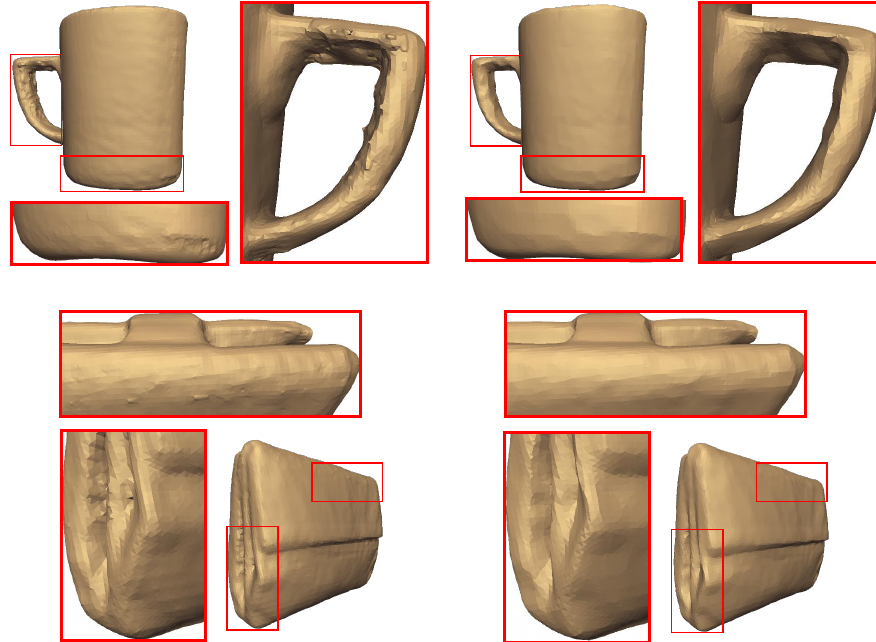
Figure 18. ( Left ) Three-dimensional scanned cup and wallet with abnormalities. ( Right ) Denoising results in respect of